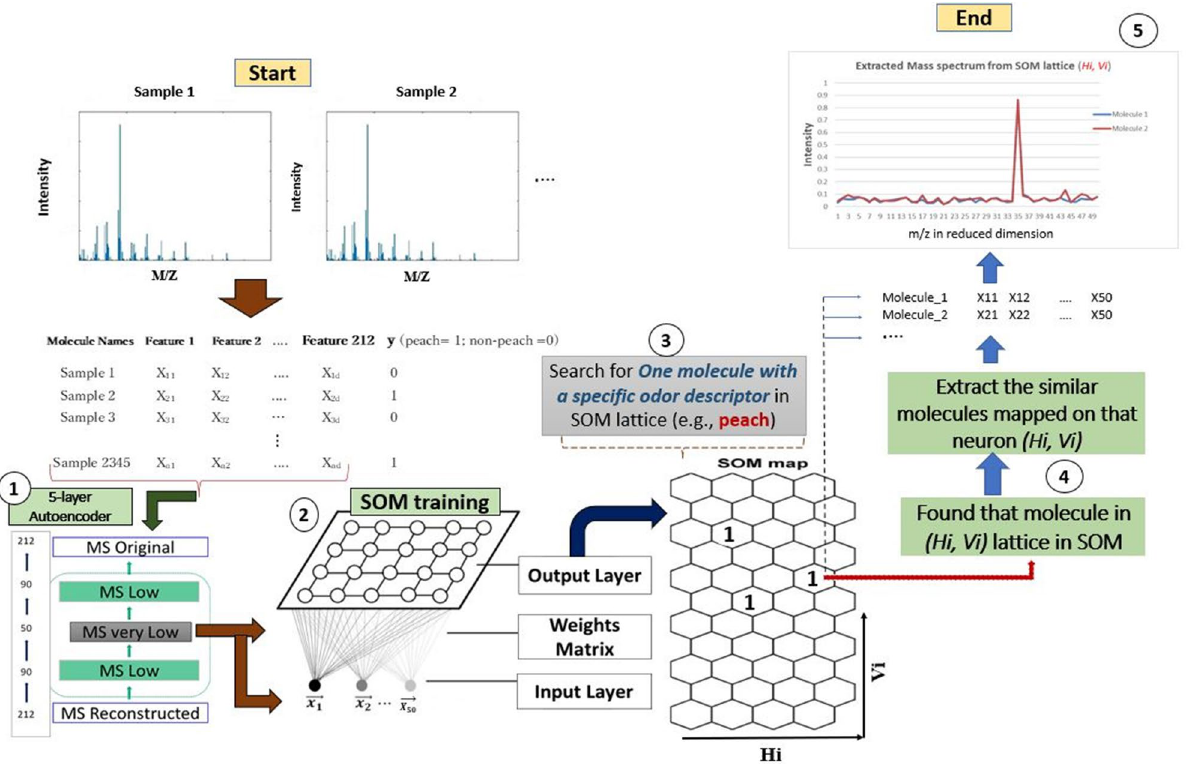
Figure 1. Method to extract sensing data (mass spectrum) for a desired scent impression.